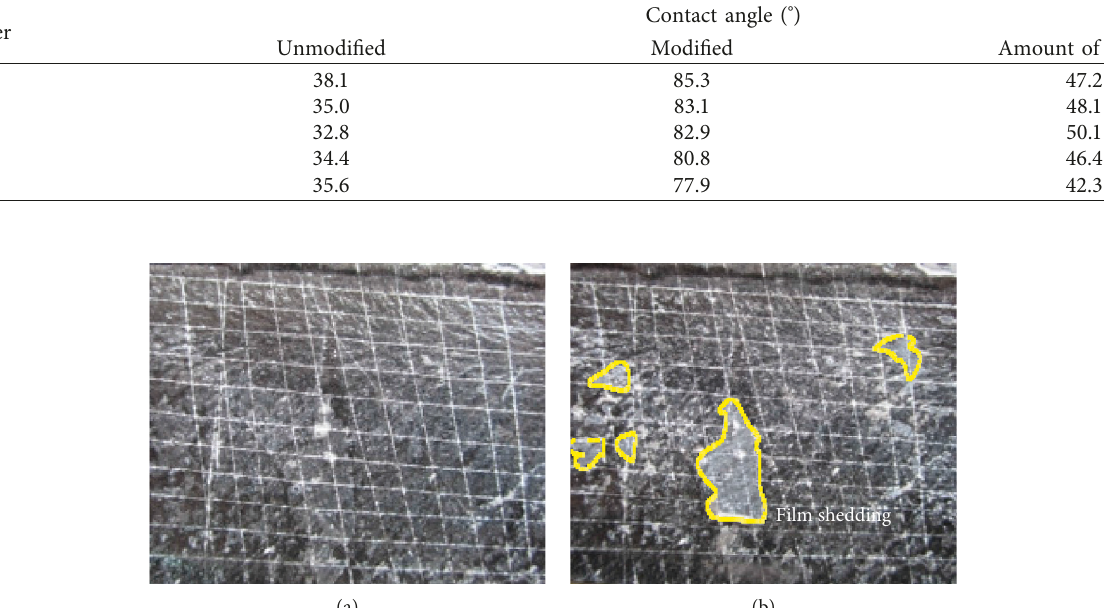
Table 2: Measured results of the contact angle on the sample’s surface.